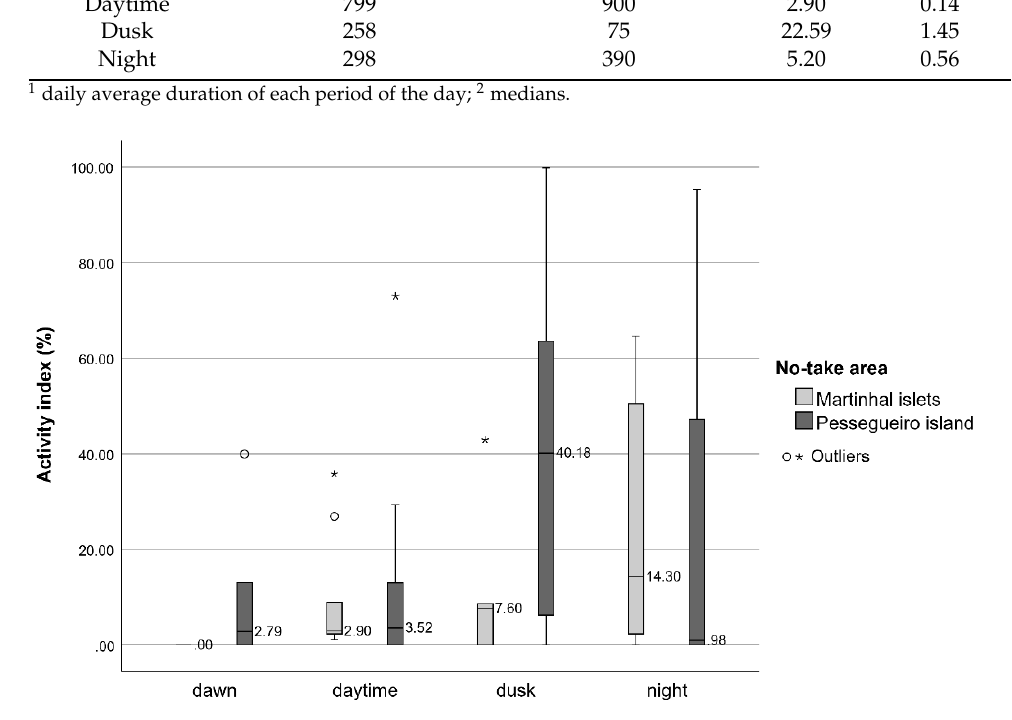
Figure 3. Boxplot of daily variation of dusky groupers’ activity levels, i.e., activity index (I A ) calcu- lated from individual fish released in the Pessegueiro island and Martinhal Islets no-take areas. Similarly, a significant circadian pattern in the amplitude of the short-distance ranging movements (N R ) was also found. Groupers performed wider movements during dusk and night periods, with significantly higher N R in these periods (Tables 2–4, and Figure